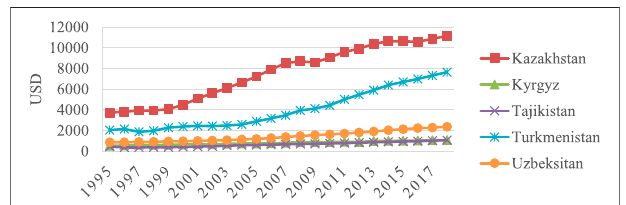
FIGURE 4 | Per capita income of central asian